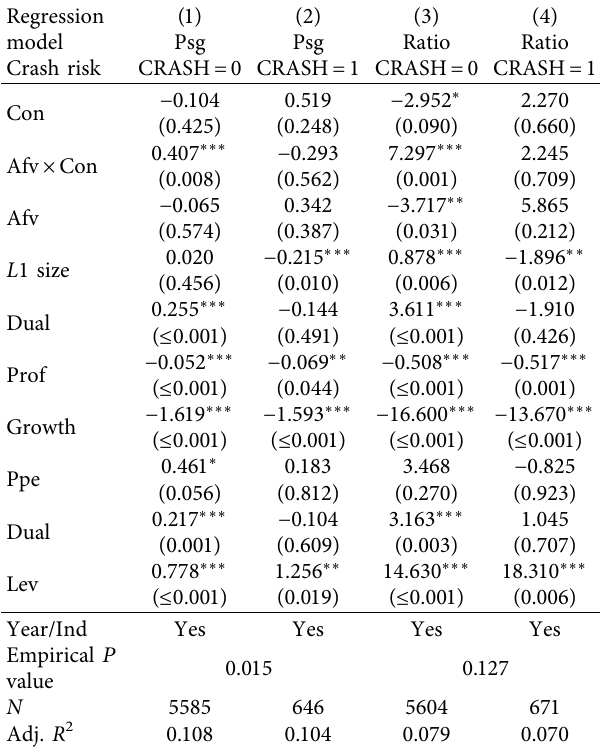
Table 8: The impact of stock price collapse risk on the adjustment of fair value measurement.